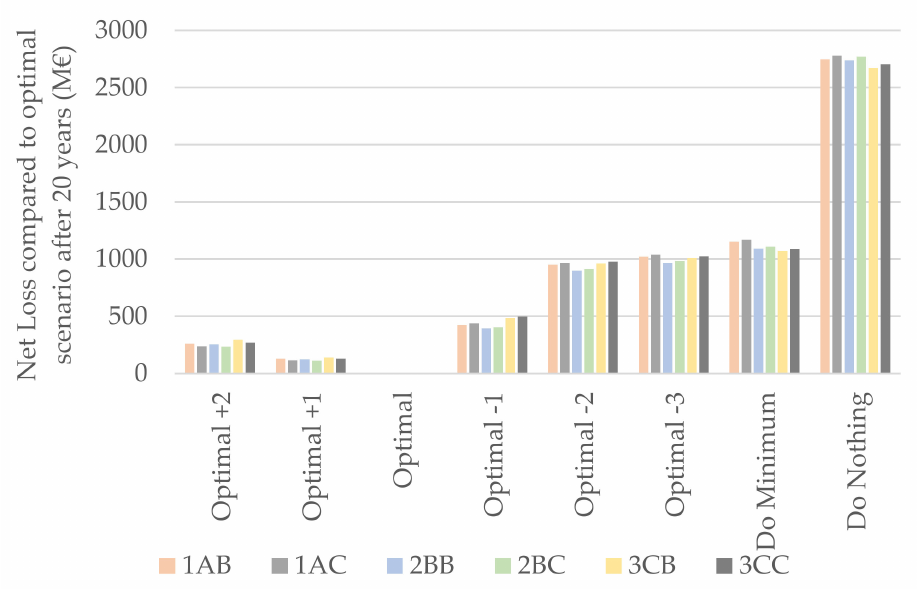
Figure 6. Annual net loss compared with an ‘Optimal’